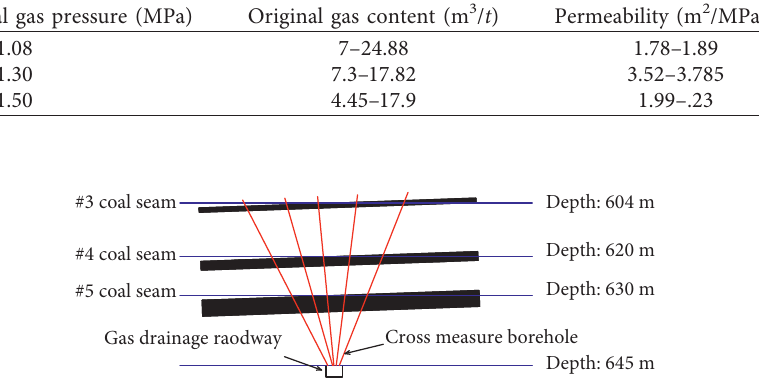
Figure 2: Illustration of the cross-measure boreholes in bed plate drainage roadway.